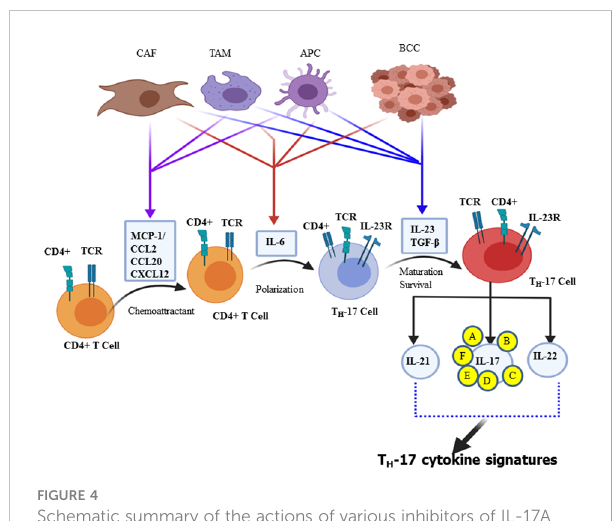
FIGURE 4 Schematic summary of the actions of various inhibitors of IL-17A and its multiple downstream signal transduction pathways. In addition to the synthetic and natural inhibitors of these signaling target molecules, extracellular signal-regulated kinase can be endogenously regulated by short negative feedback loop via dephosphorylation, dual-speci fi city